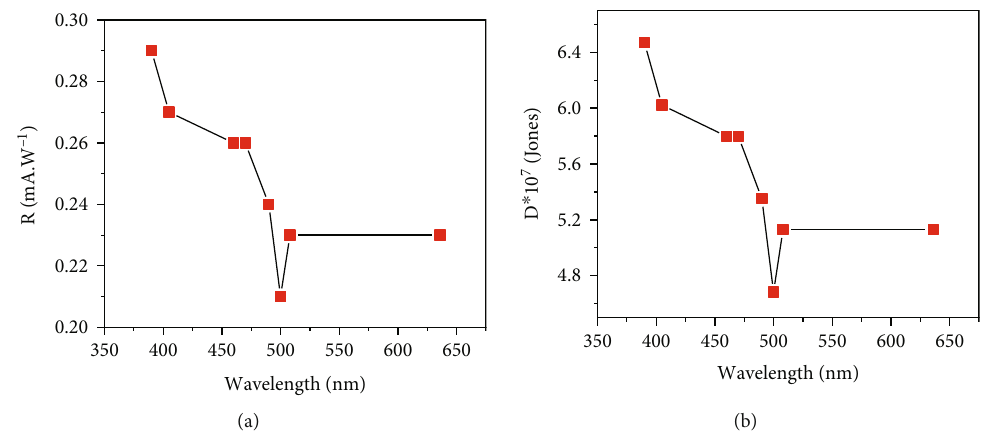
Figure 6: (a) R and (b) D values of the glass/P3MA/PbS Table 2: Comparison of the photoresponsivity of the synthesized glass/P3MA/PbS photodetector with previous works.